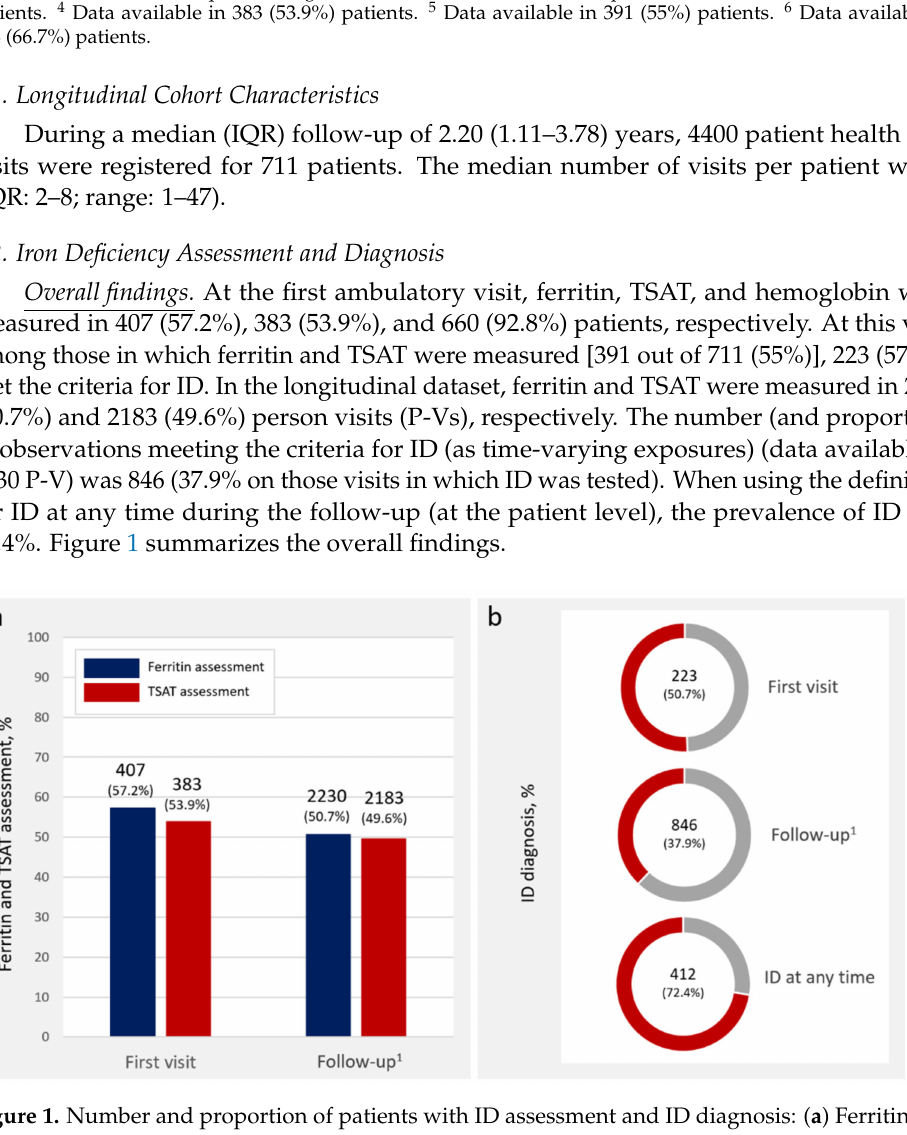
Figure 1. Number and proportion of patients with ID assessment and ID diagnosis: ( a ) Ferritin and TSAT assessment; ( b ) ID diagnosis. 1 Person visits. ID: iron deficiency; TSAT: transferrin